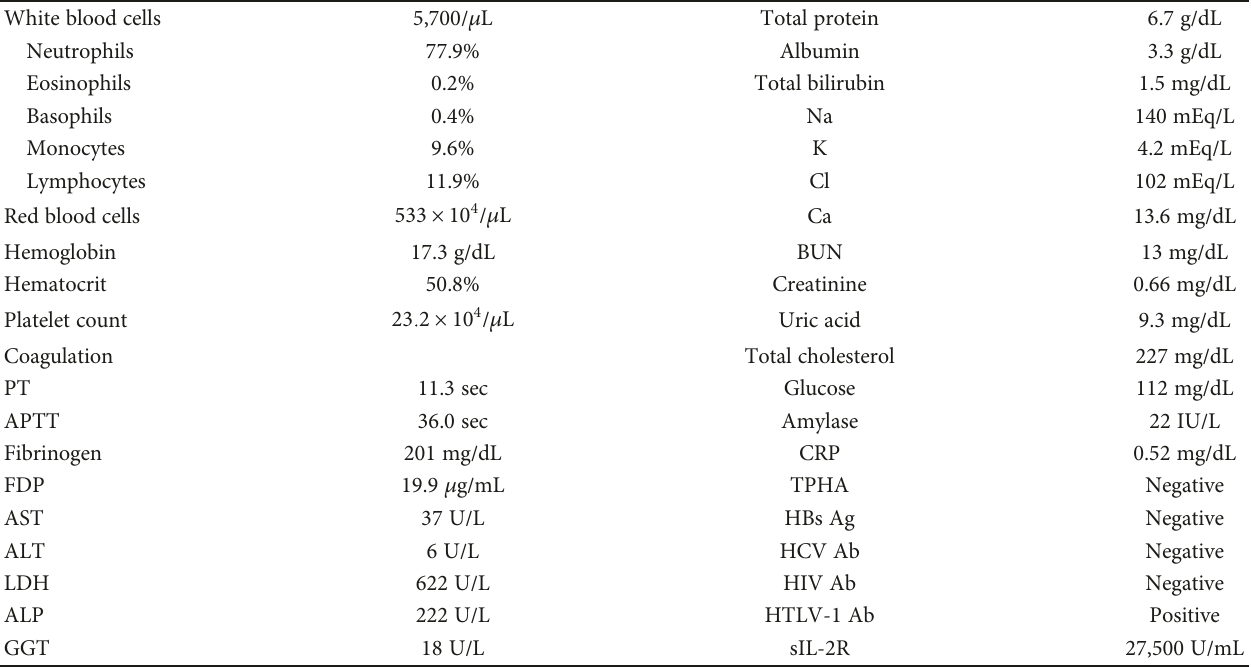
Table 1: Laboratory fi